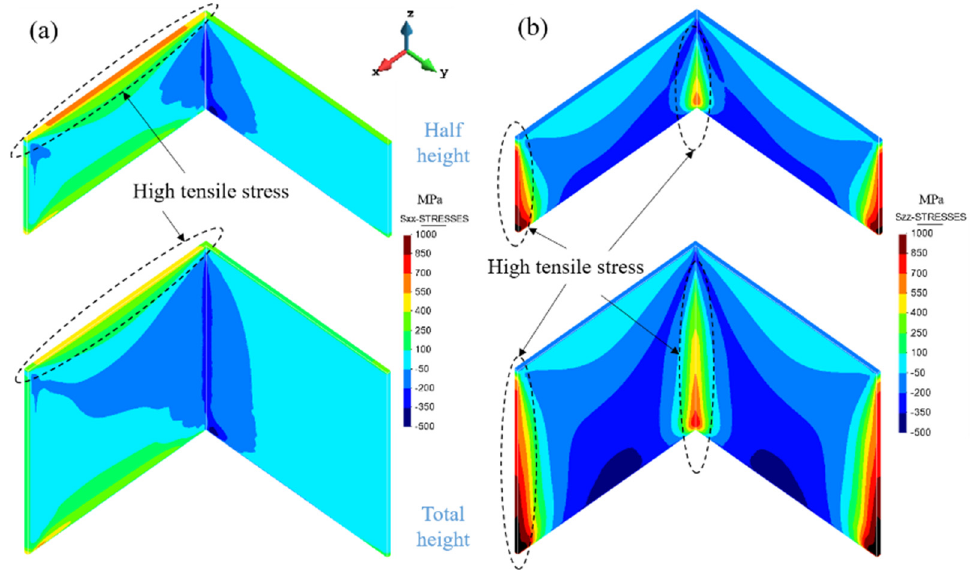
Figure 13. L-shape component: evolutions of ( a ) longitudinal stresses and ( b ) vertical stresses.